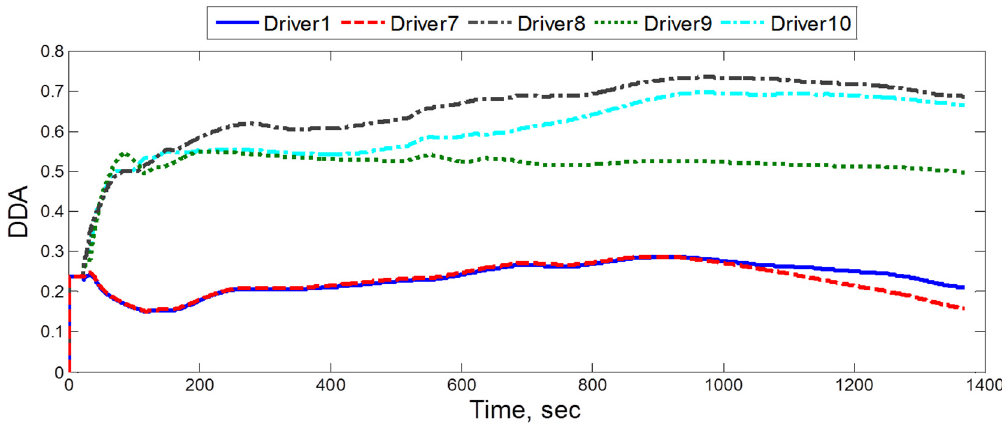
Figure 9. Degree of driver aggression for five driver